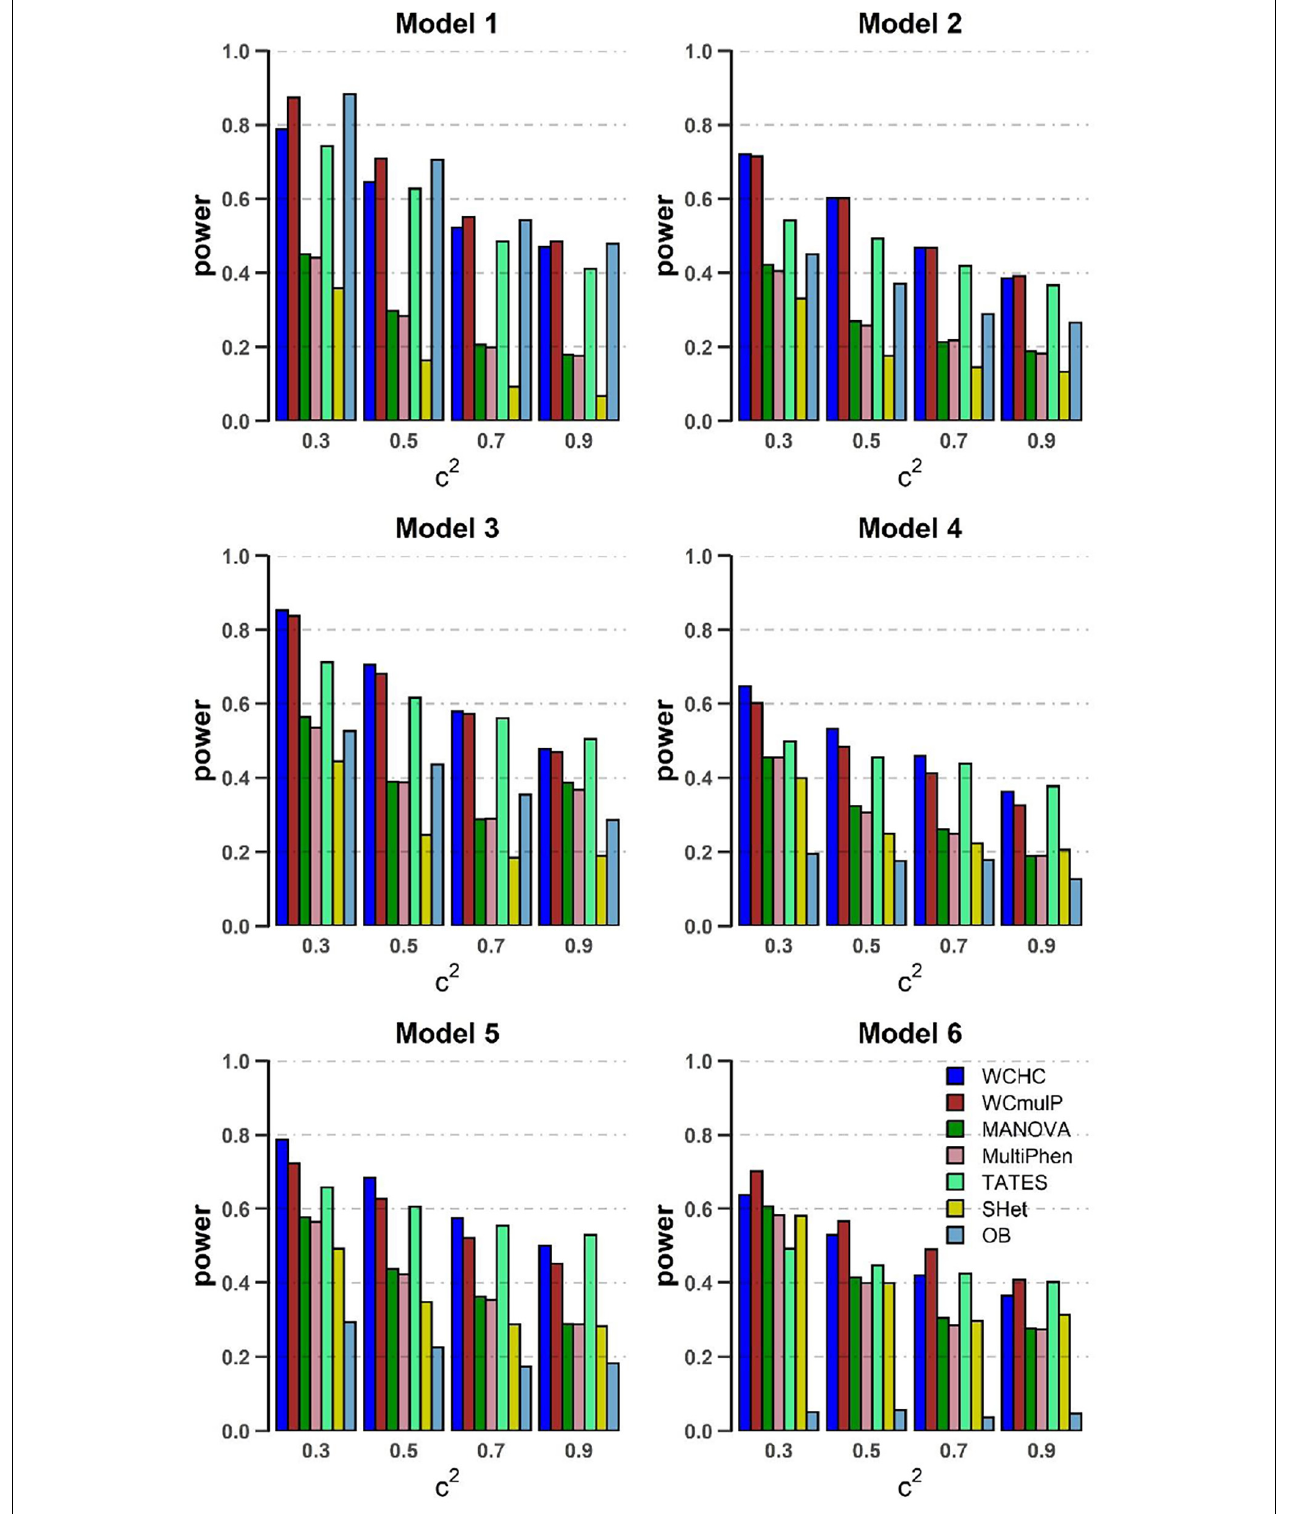
FIGURE 3 | Power comparisons of the seven methods as a function of c 2 in the six models. Sample size is N = 1,000, the number of phenotypes is M = 16, ρ c 2 = 0.1 and MAF = 0.3. β = 0.09 for model 1 and 2; β = 0.08 for model 3; β = 0.1 for model 4 and 5; β = 0.07 for model 6. The power of all the seven methods is estimated by 1000 replicated samples at a significance level of